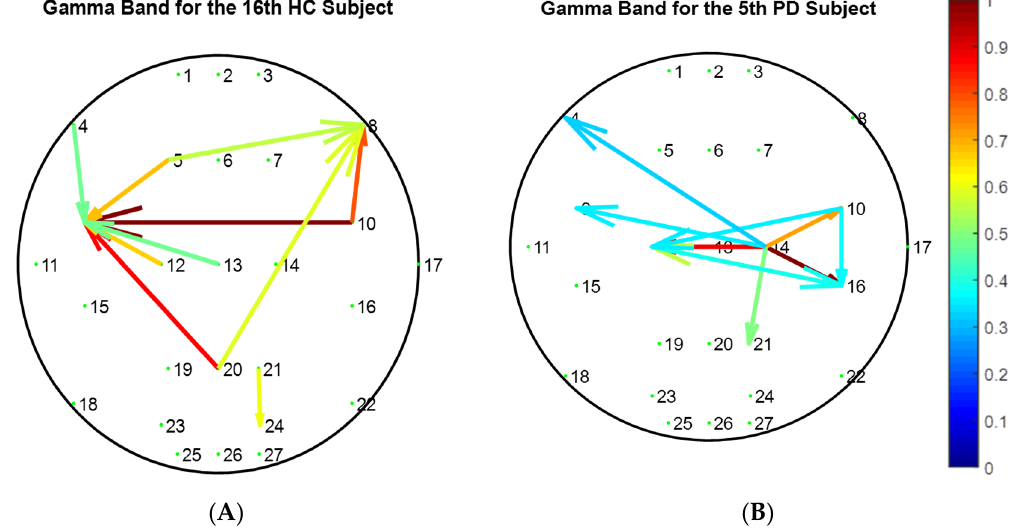
Figure 7. 10 highest normalized directional connections’ values that cause maximum value in feature related to the maximum LASSO coefficient for non-latent space: ( A ) Right finger tap test; ( B ) Left finger tap test.